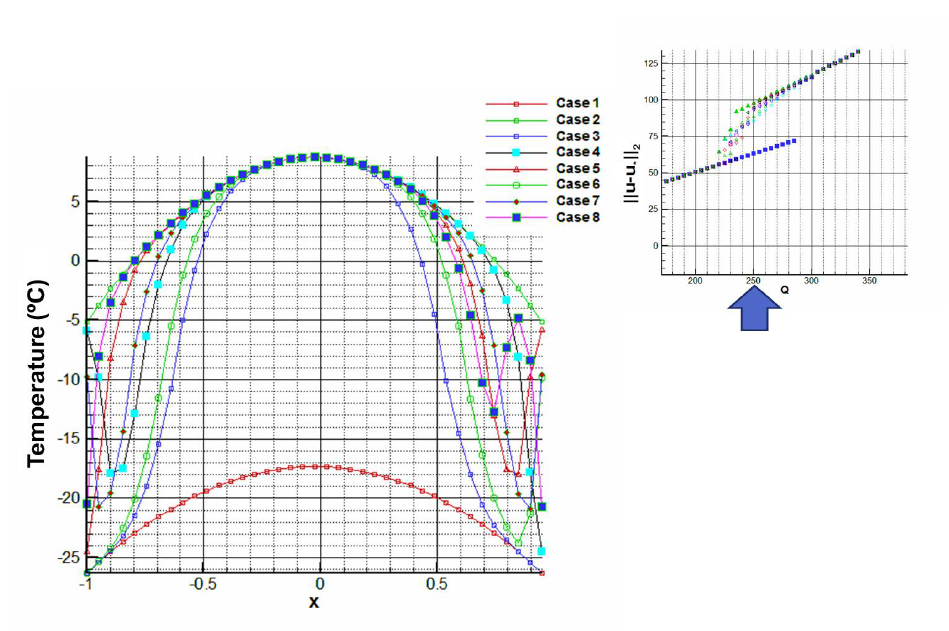
Figure 10. Multiple stationary solutions. Coupled model. Q =